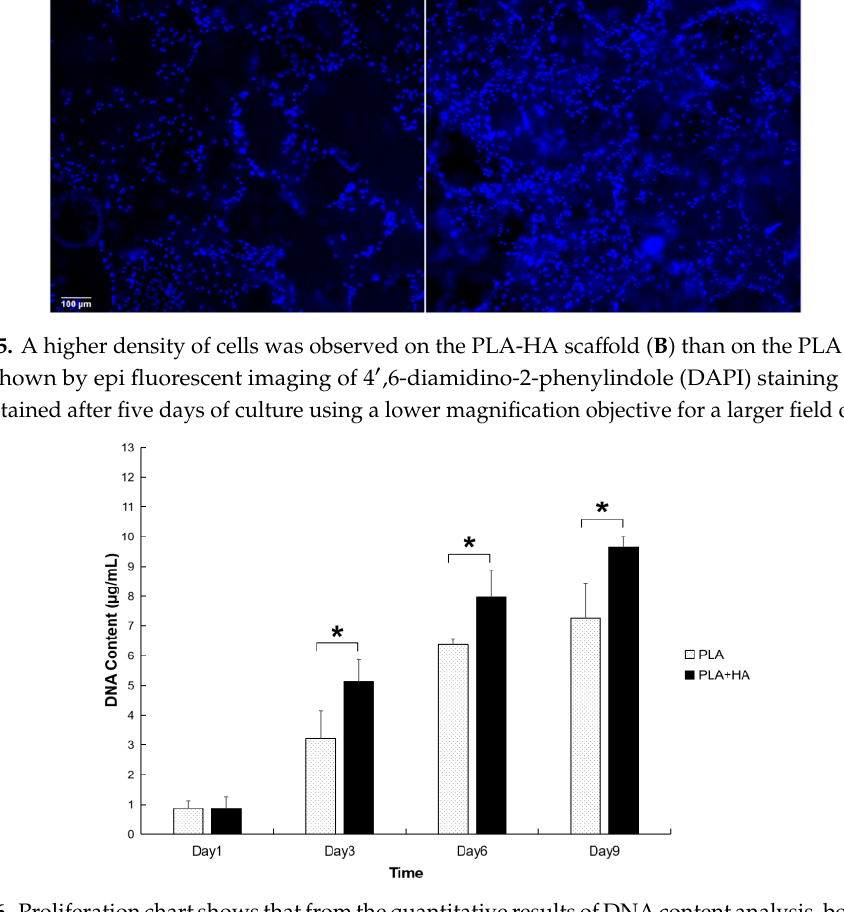
Figure 6. Proliferation chart shows that from the quantitative results of DNA content analysis, both types of scaffolds support cell growth with the PLA-HA group showing a significantly higher proliferation rate than the PLA group starting from day 3 to day 9. * indicates p < 0.05.